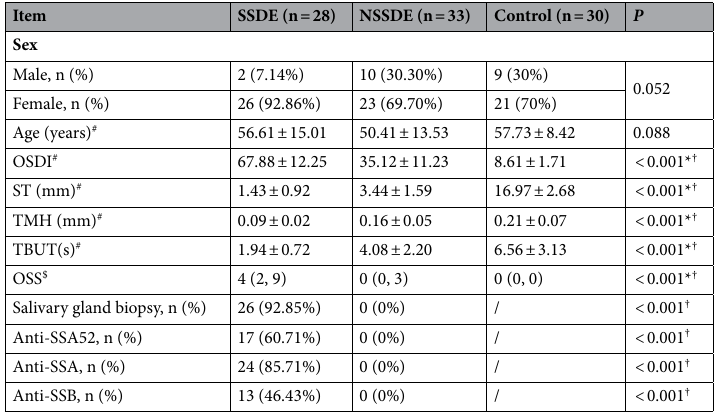
Table 1. The demographics and clinical data of the three groups. SSDE Sjogren’s syndrome dry eye, NSSDE non-Sjogren’s syndrome dry eye, OSDI ocular surface disease index, ST Schirmer test, TMH tear meniscus height, TBUT tear film breakup time, OSS ocular staining score, anti-SSA anti-Sjogren’s syndrome A, anti-SSB anti-Sjogren’s syndrome B. # Mean ± standard deviation; $ Median (25% quantile, 75% quantile). * P < 0.05 among the three groups; † P < 0.05 between SSDE and